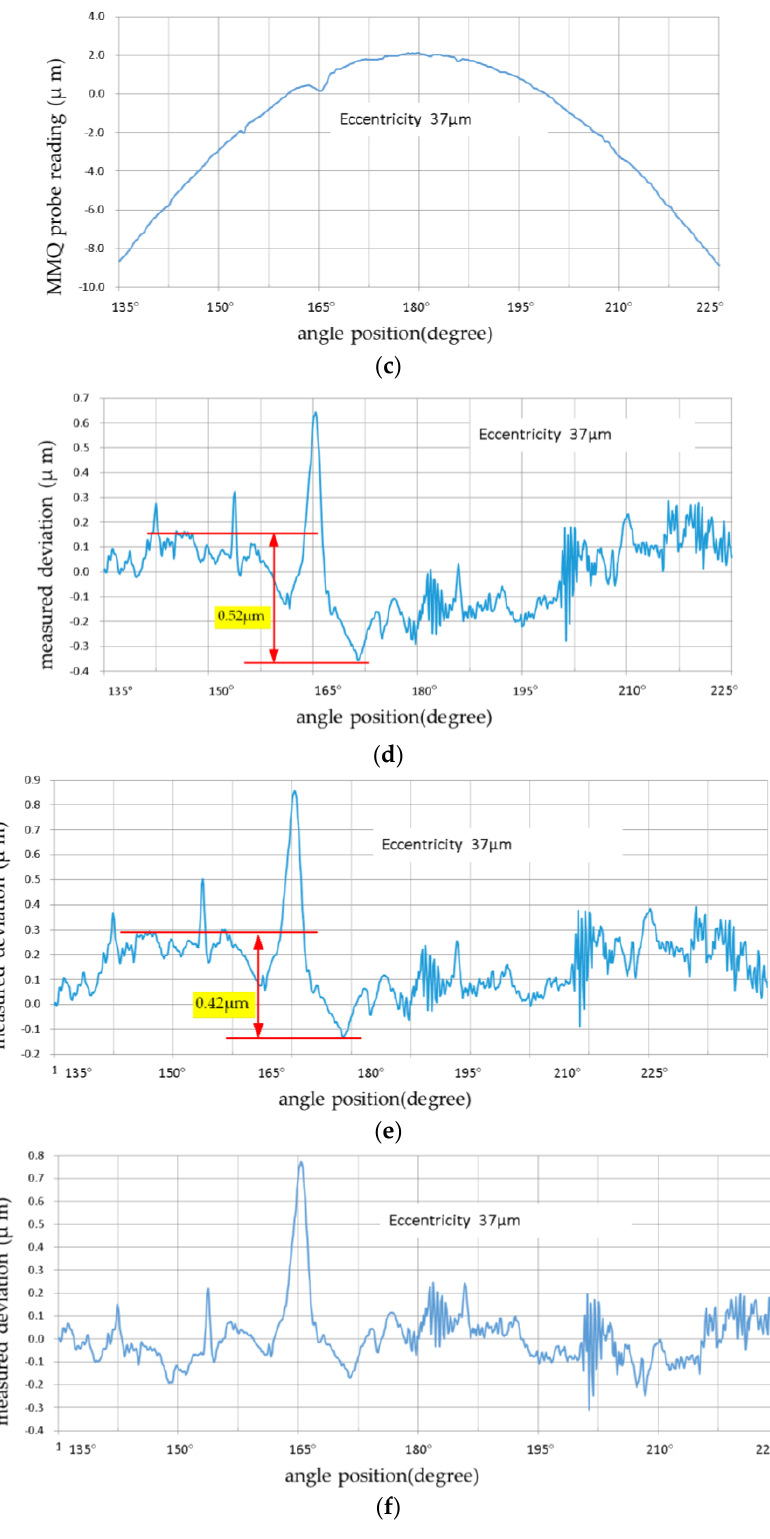
Figure 12. Eccentricity 37 μm measurement results with nonlinear and linear correction: ( a ) Capacitance sensor values after nonlinear correction; ( b ) Capacitance sensor value after linear correction; ( c ) MMQ400 probe readings at eccentricity 37 μm; ( d ) Measurement deviations with capacitive sensor nonlinear correction; ( e ) Measurement deviations with capacitive sensor linear correction (2 points); and ( f ) Measurement deviations with capacitive sensor linear correction (3 points).